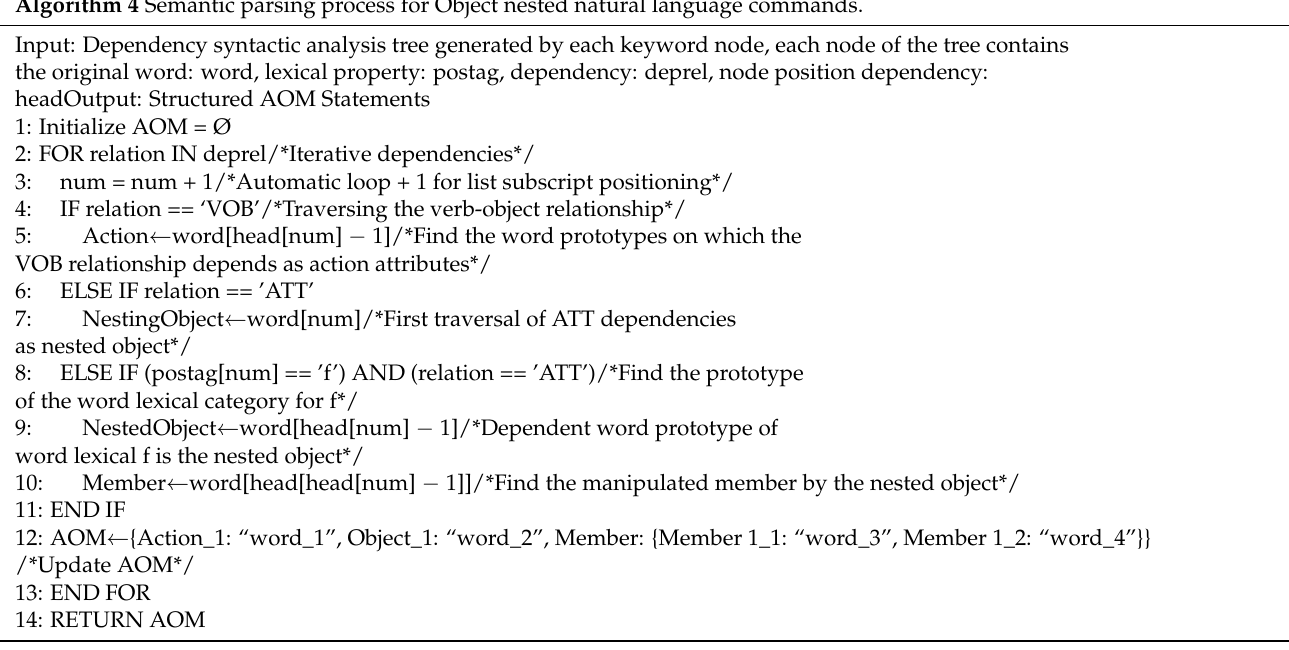
Algorithm 4 Semantic parsing process for Object nested natural language